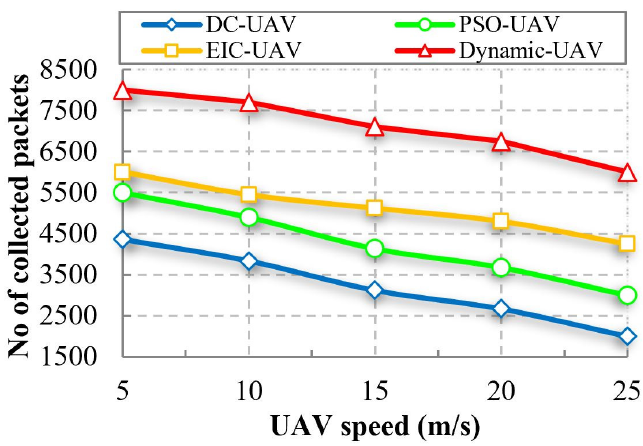
Figure 13. Number of the collected packet compared to UAV speed.